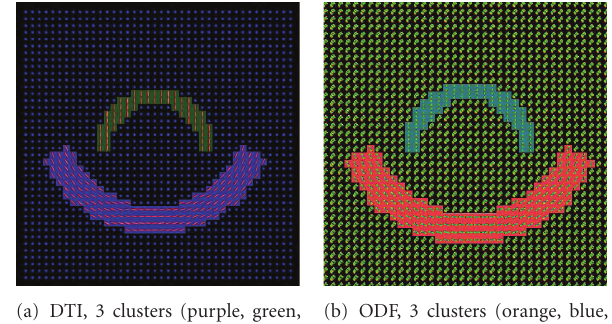
Figure 4: Synthetic DT and ODF images. The expected number is four, one for each fiber, one for the crossing between the two fibers and one for the